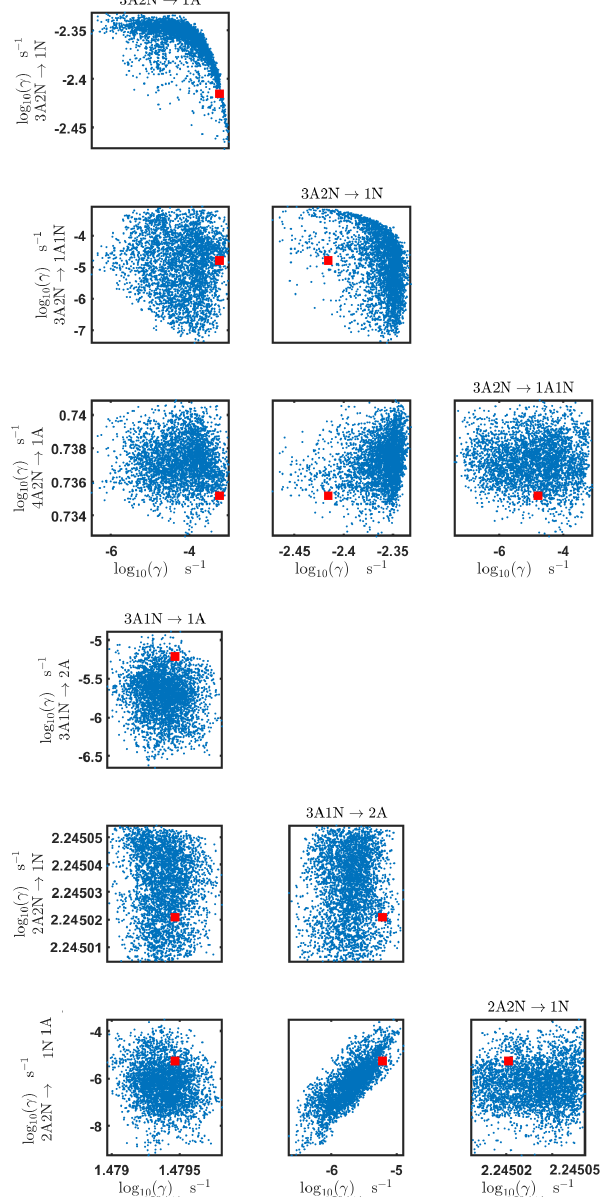
Figure C4. Pairwise marginal posterior distributions (for parameter indexes ranging from 1 to 8) of the base 10 logarithm of the evapo- ration rates (units given in s − 1 ) determined from time-dependent measurements of the cluster concentrations with time resolution comprising 1.5min at the temperature 278K. Red rectangles denote the baseline values from Olenius et al. (2013b) used to generate the synthetic data. The notation xAyN corresponds to a cluster with x sulfuric acid and y ammonia molecules.